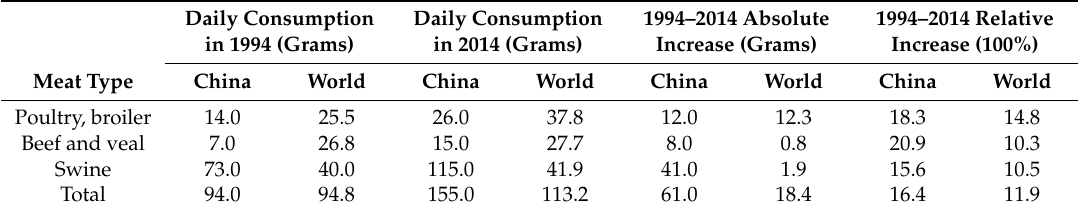
Table 3. Daily per capita meat consumption and its changes, China and world average. Data